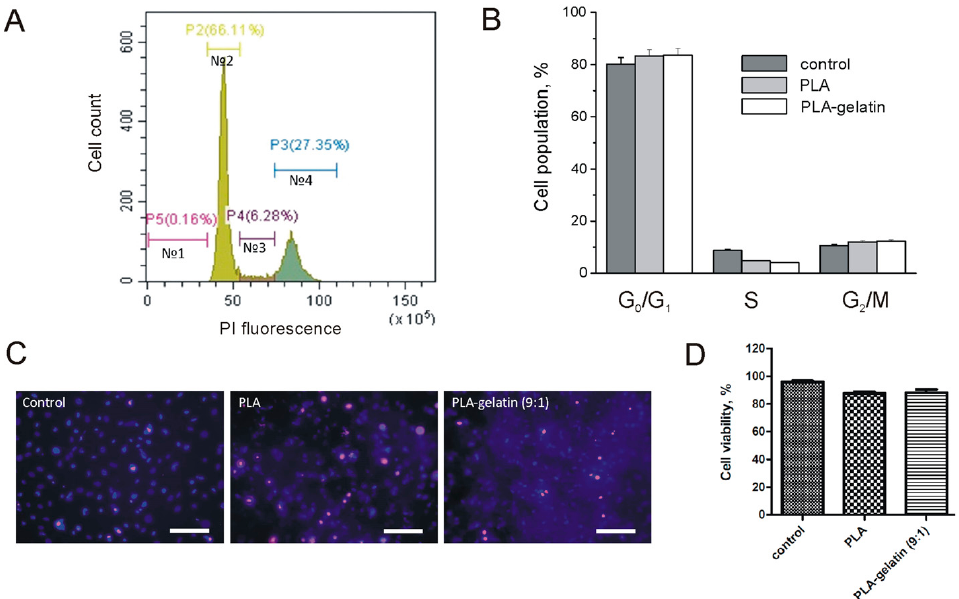
Figure 7. Analysis of proliferation rate and viability of 3T3 fibroblasts cultured on PLA and PLA– gelatin electrospun mats. ( A ) A typical view of the DNA profile of the 3T3 cell population, where zones 1, 2, 3, and 4 correspond to the apoptotic, G0/G1-phase, S-phase, and G2/M-phase cell fractions. ( B ) Fractions of 3T3 cells, cultured on PLA, PLA–gelatin electrospun mats, and on culture plastic (control). ( C ) Merged photographs of 3T3 fibroblasts, cultured on different materials, after staining with Hoechst 33342 (blue cell nuclei) and PI (red cell nuclei). The scale bar is 100 µ m. ( D ) Viability of the fibroblasts, cultured on PLA, PLA–gelatin electrospun mats, and on culture plastic (control).